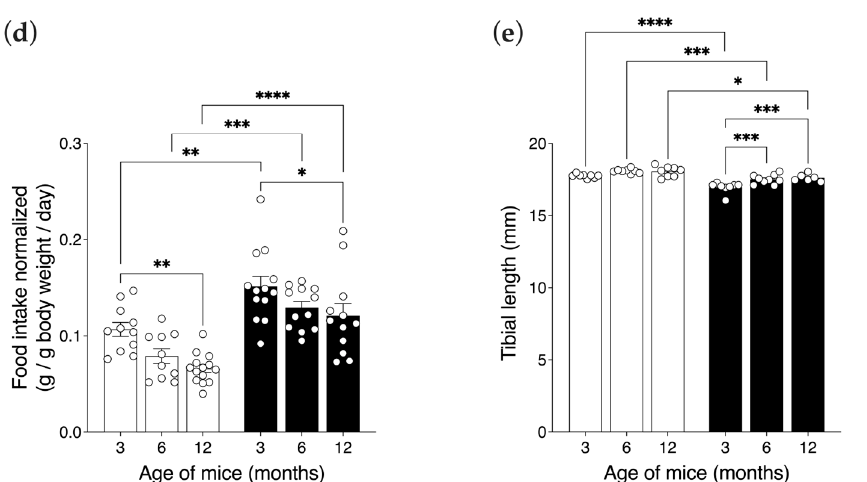
Figure 2. Taz -KO mice display a growth deficiency and smaller physical size at all ages measured. Growth curve showing the body weight of mice from 4 to 75 weeks of age ( n = 10) ( a ). Body weight ( n = 6–8) ( b ), absolute food intake ( n = 10–14) ( c ), food intake normalized to total body weight ( n = 10–14) ( d ), and tibial lengths ( n = 6–8) ( e ), were determined at 3, 6, and 12 months of age. Data are means ± SEM. Statistical analyses were performed using two-way ANOVA followed by Bonferroni’s multiple comparisons tests. * p < 0.05, ** p < 0.01, *** p < 0.001, **** p < 0.0001.